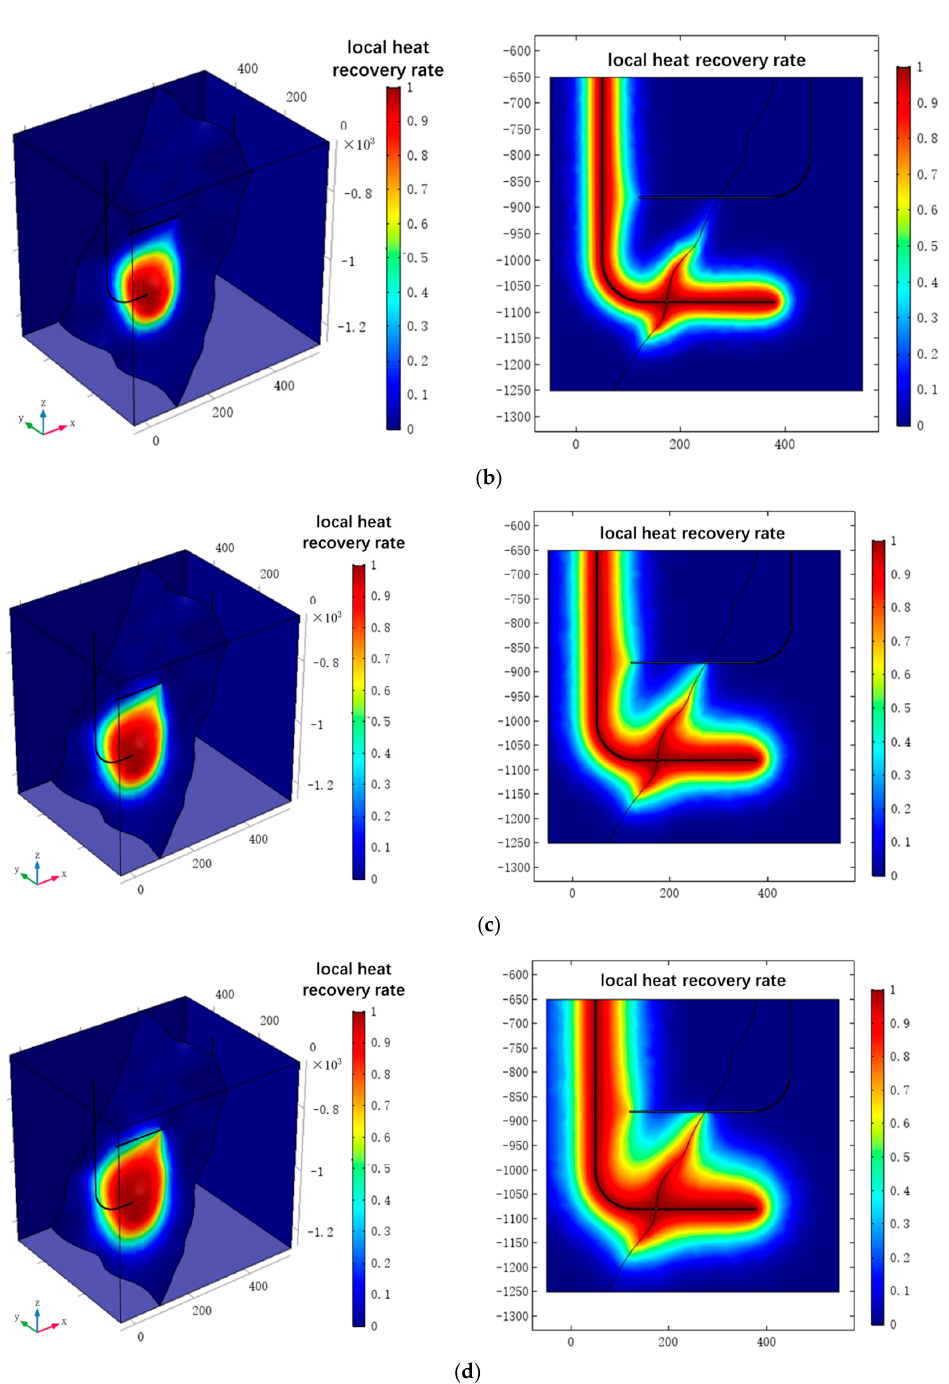
Figure 8. Local heat recovery rate distribution in reservoir and y = 250 m surface at different times; ( a ) t = 1a; ( b ) t = 15a; ( c ) t = 30a; ( d ) t = 45a. Figure 9 indicates the evolution of the overall heat recovery rate, calculated according to Equation (25). From the overall heat recovery effect evaluation of the dual horizontal well system, the overall thermal recovery rate and the matrix rock average temperature both have a linear relationship with time, because the temperature drop has not reached the upper and lower boundaries, which can maintain a constant heat supply. It can be inferred that the overall thermal rate growth will decline over time when the temperature drop spreads to the upper and lower boundaries. After 45 years of operation, the exploited heat energy accounts for a small proportion of